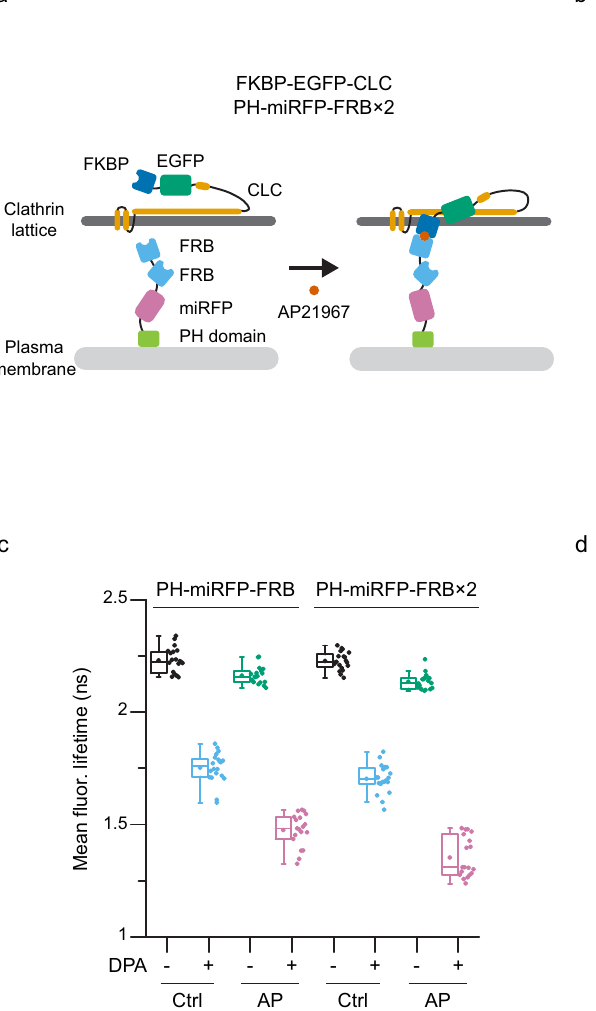
with PH-miRFP-FRB, or PH-miRFP-FRB×2 without or with 20 μ M DPA. Cells were unroofed after 15min incubation with AP21967 or ethanol (control). n =20 (PH- miRFP-FRB, control), 19 (PH-miRFP-FRB, AP21967), 20 (PH-miRFP-FRB×2, control), and 19 cells (PH-miRFP-FRB×2, AP21967) from 3 experiments. d Differences in fl uorescencelifetimes (shown inpanel c)without and withDPA. For box plots, box is interquartile range, center line is median, center circle is mean, whiskers are minimum and maximum data points with acoef fi cient value of 1.5. Source data are provided as a Source Data fi